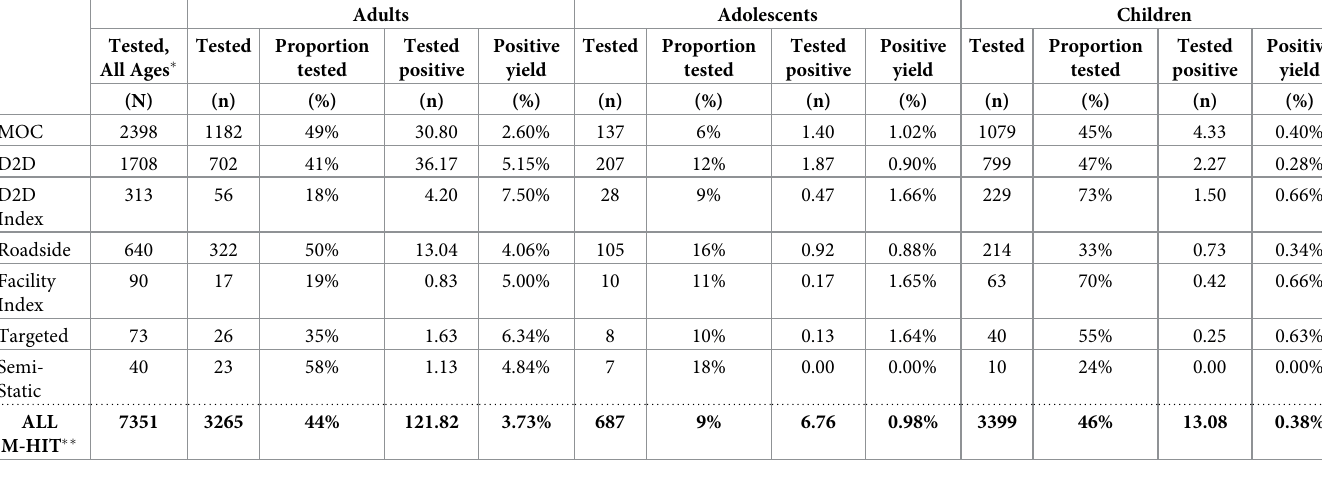
Table 2. Average monthly number tested, proportion tested, number tested positive, and yields; stratified by age group for all M-HIT strategies. Tested, Tested Proportion All Ages �